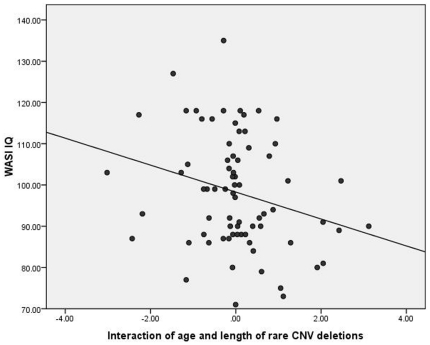
Scatterplot of the relationship between length of total rare deletions (base pairs) and Full Scale Intelligence Quotient (r = −.30, p = .01).